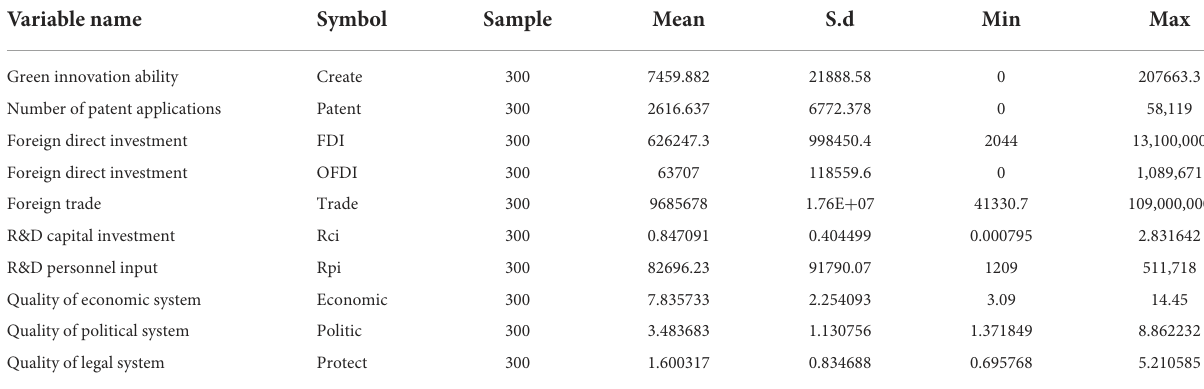
TABLE 2 Statistical description of variables.